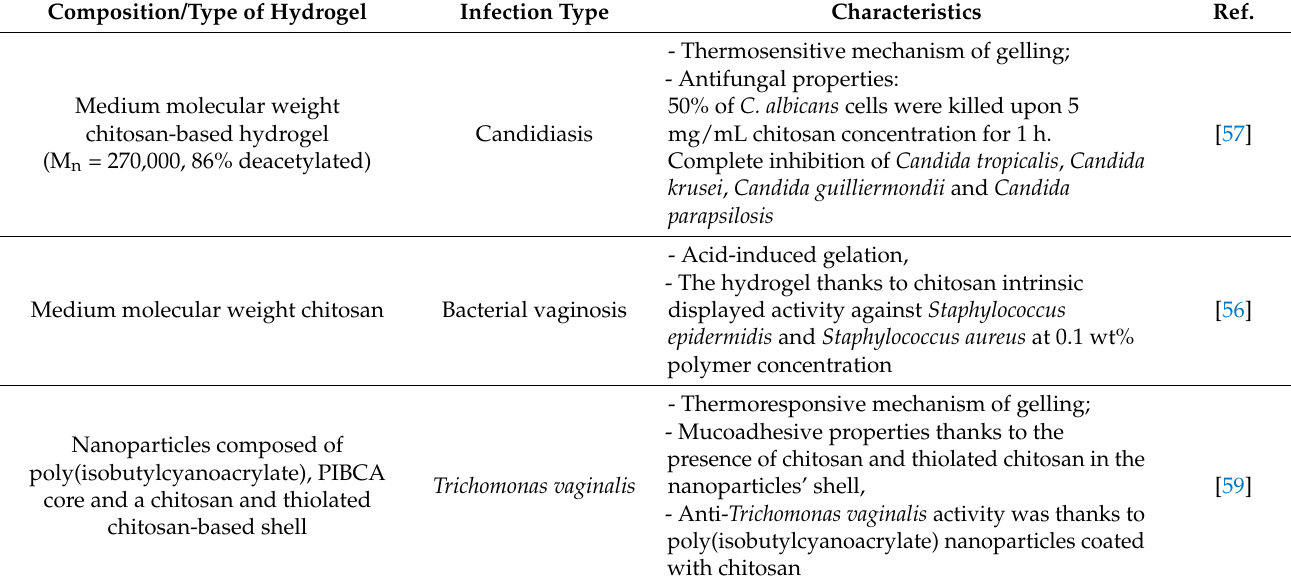
Table 2. Examples of polymer-based hydrogel systems displaying intrinsic antimicrobial properties. Composition/Type of